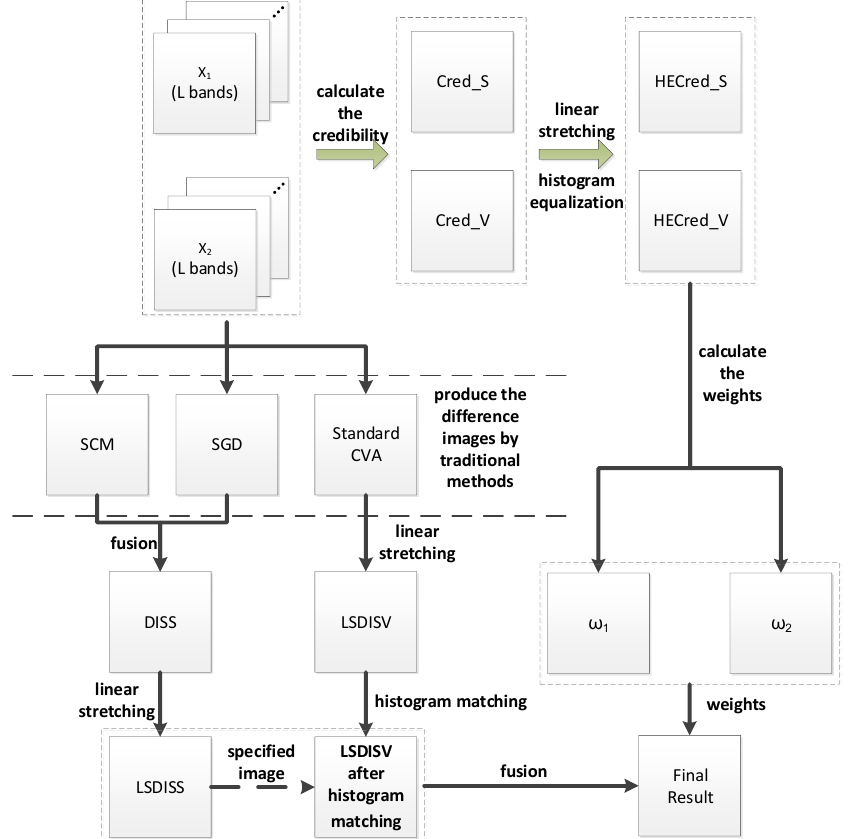
Figure 2. The flowchart of the proposed algorithm.